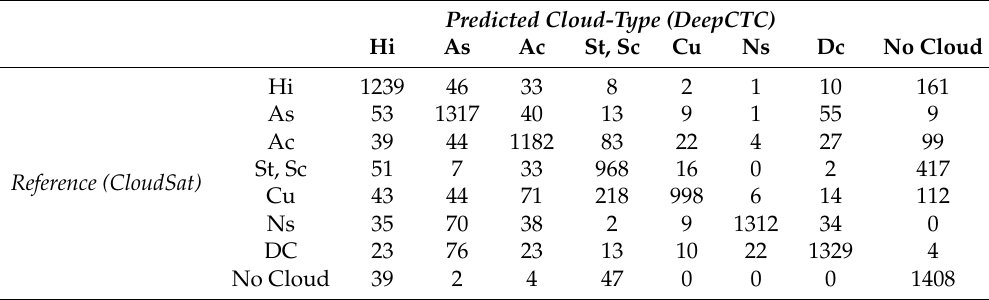
Table 3. Confusion matrix ( ∼ 12,000 total test samples).